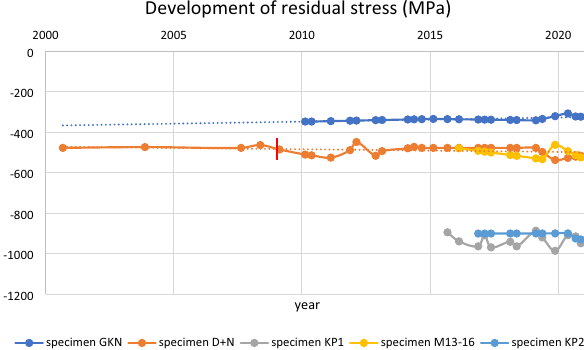
Fig. 8 Development of compressive residual stress over the course of the investigation with two linear fits (D + N,